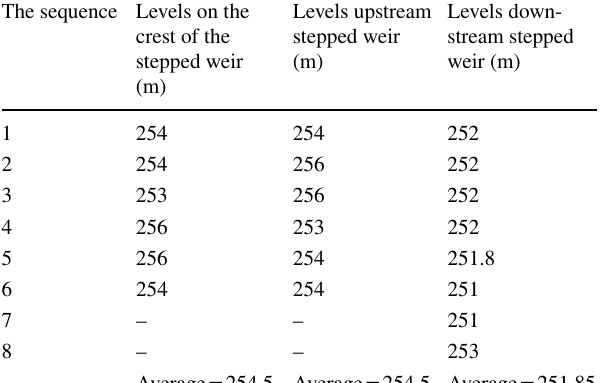
Table 1 The levels of stepped weir using the QGIS 3.4.2 program The sequence Levels on the crest of the